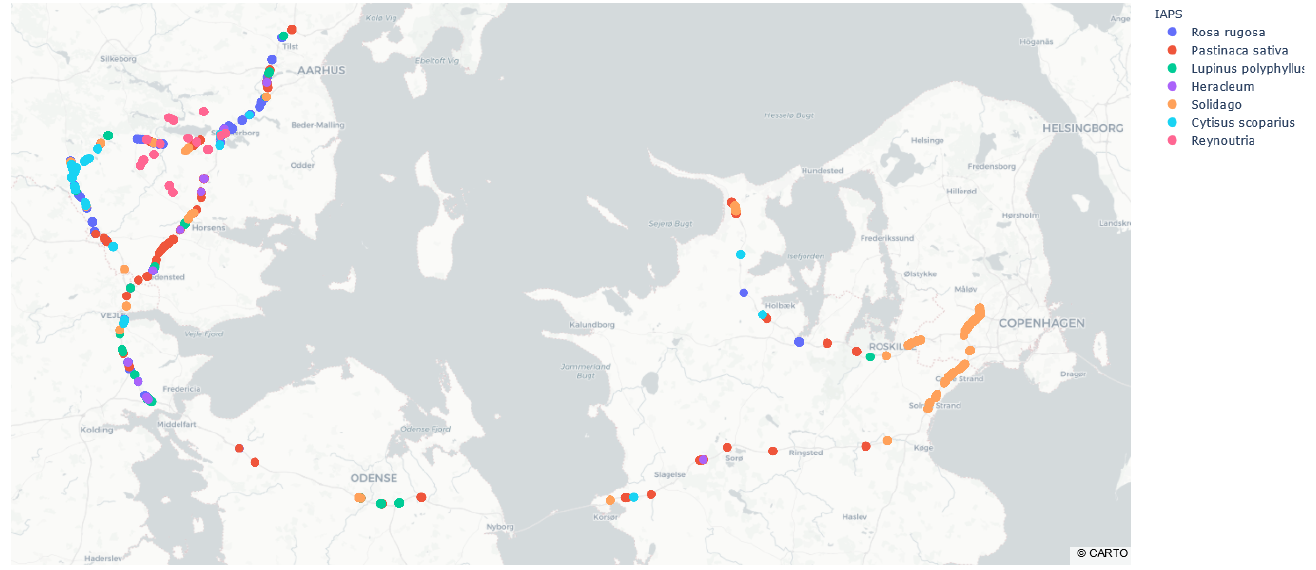
Figure 5. Overview of the collected images and